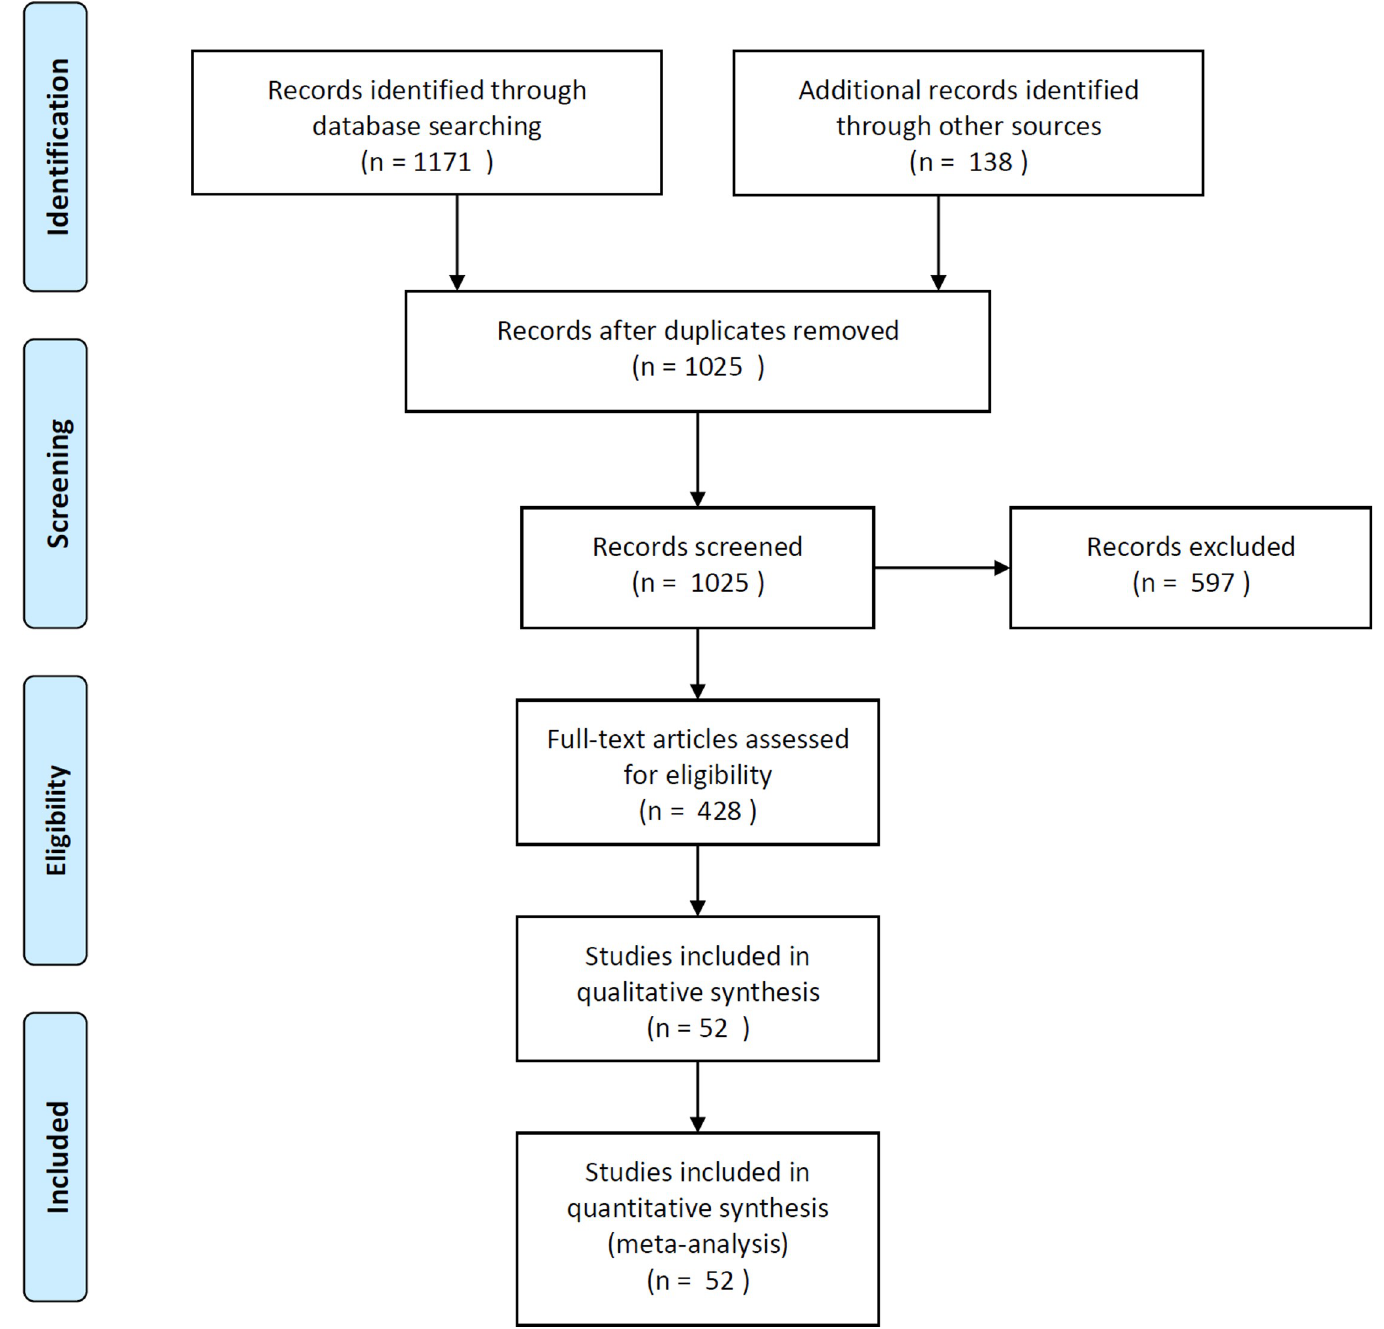
Fig 1. PRISMA flow diagram. Mainly studies were excluded because they only reported incidence rates of ischemic stroke or TIA patients without further clinical information on those